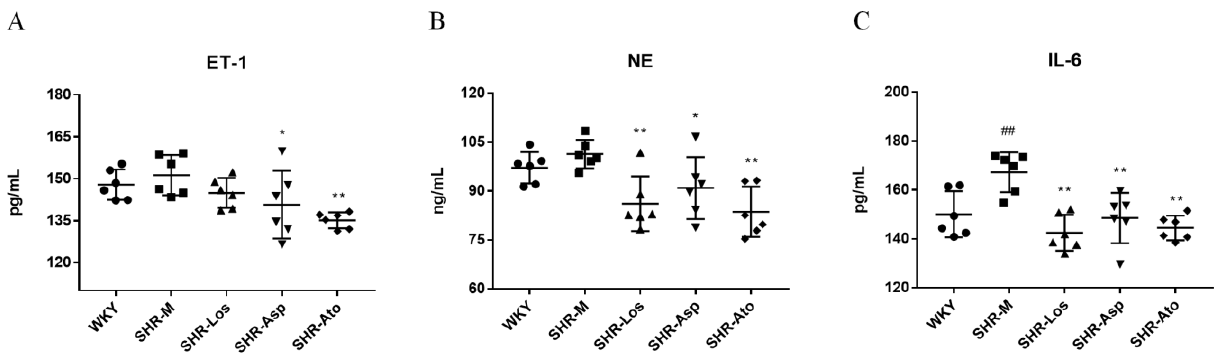
Figure 7. Effects of losartan, aspirin, and atorvastatin on the plasma contents of ET-1 ( A ), NE ( B ),